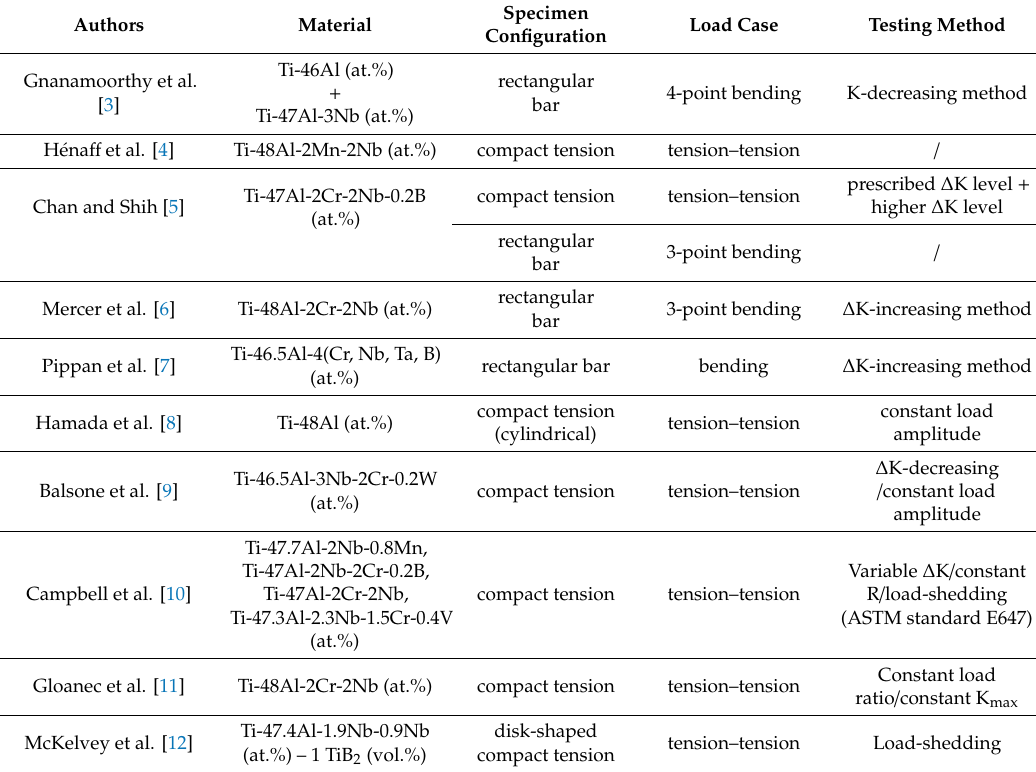
Table 1. Examples of specimen conditions and testing methods on measuring the fatigue threshold values ( ∆ K th ) and fatigue crack growth (FCG) curves in lamellar TiAl